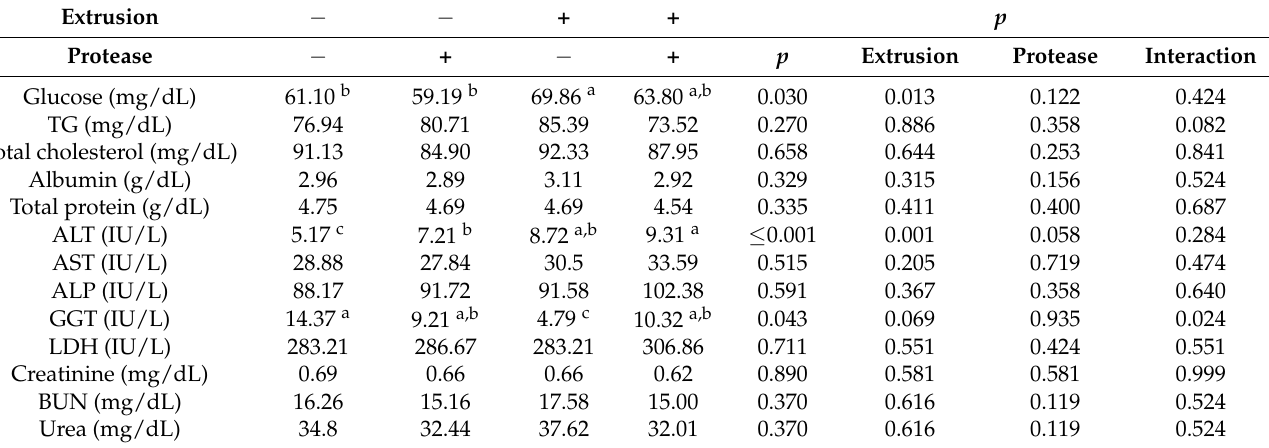
Table 8. The pigs’ blood biochemical indexes ( n =